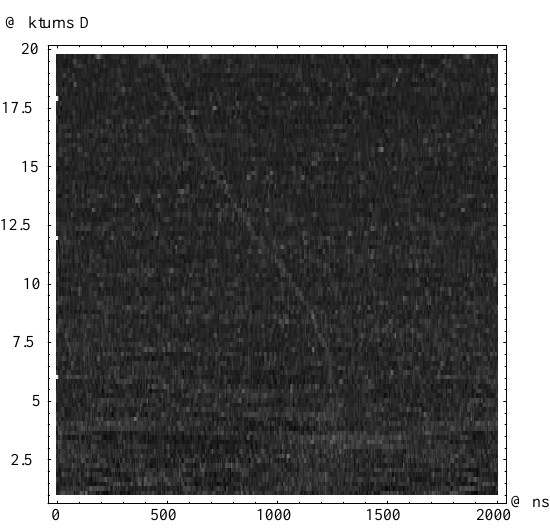
FIG. 6. 1.7 3 10 12 protons, one trace each 200 turns, vertical span 31.7